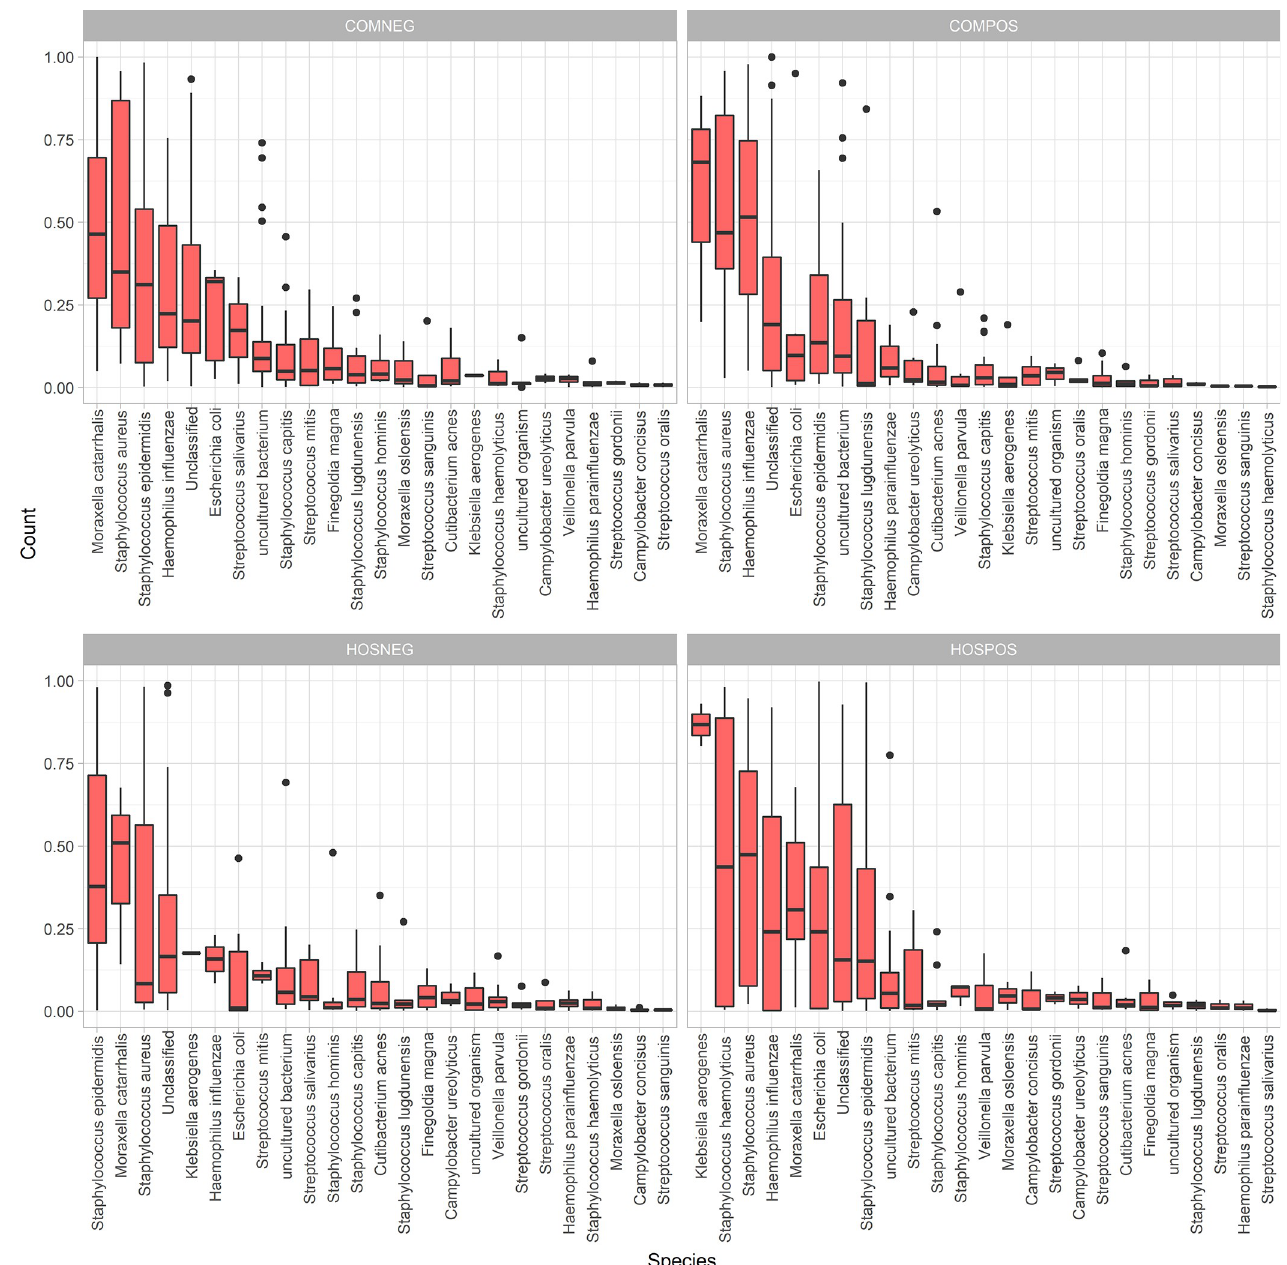
Fig 3. Species-level relative abundance. Side-by-side boxplots of relative abundance at the species-level among our four study groups. Only taxa with an overall prevalence greater than 5% across all samples are shown (i.e., taxa required to be present in 10 out of 194 samples). Taxa are ordered from highest to lowest mean relative